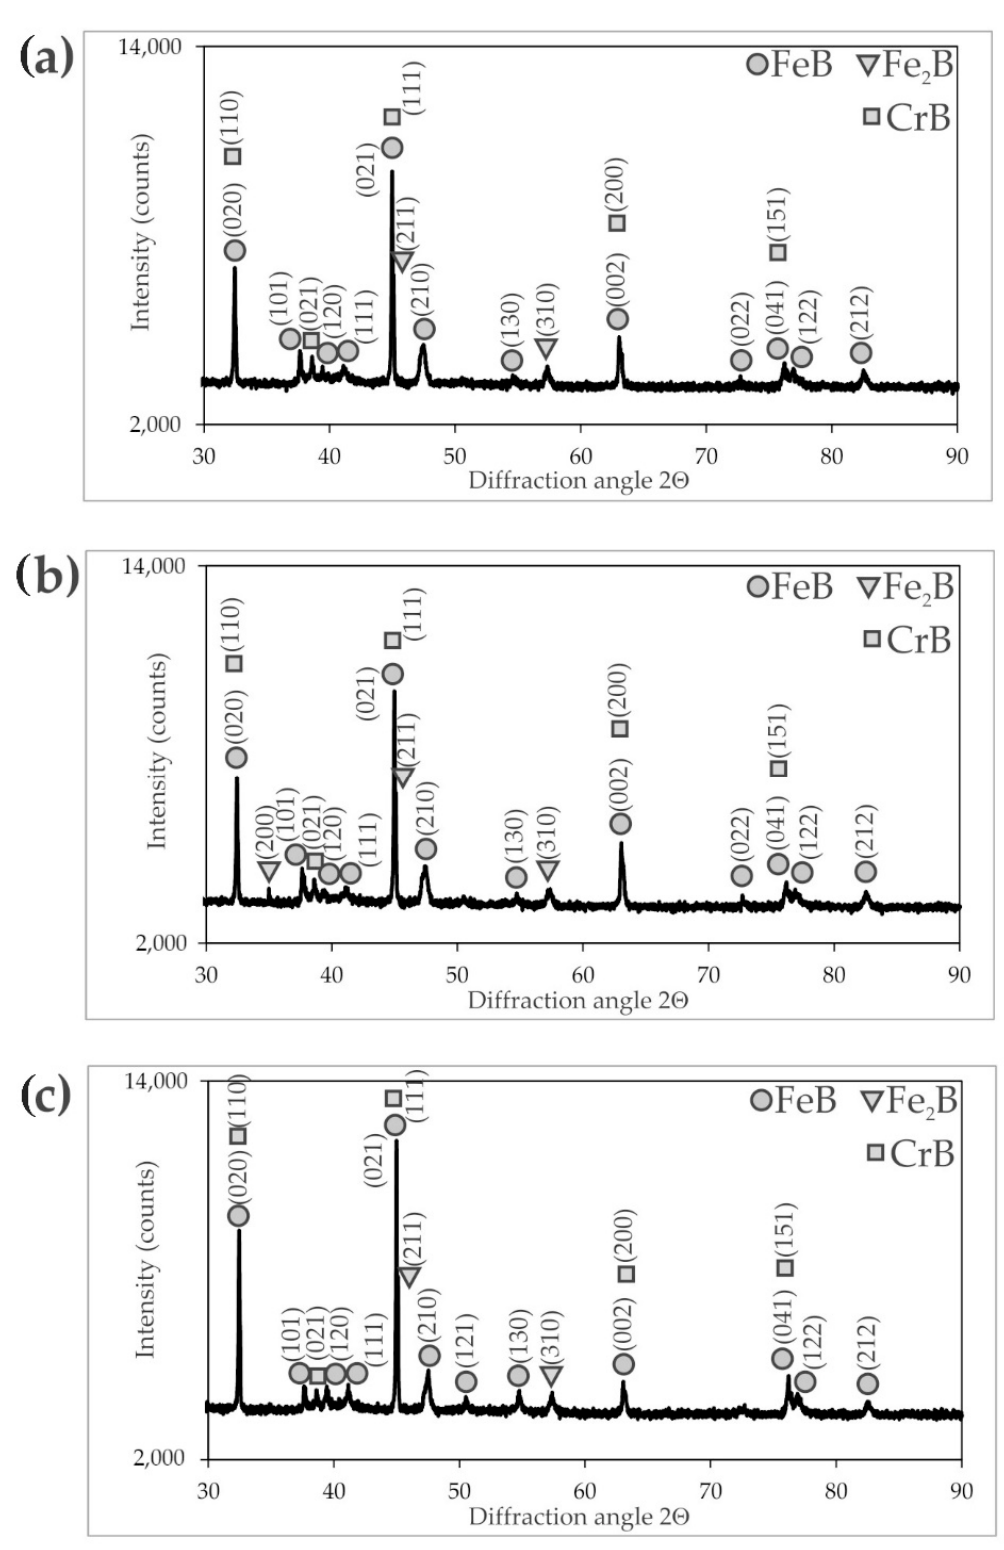
Figure 5. XRD patterns of X165CrV12 steel after powder-pack boriding at 1223 K: ( a ) for 3 h, ( b ) for 6 h, ( c ) for 9 h.